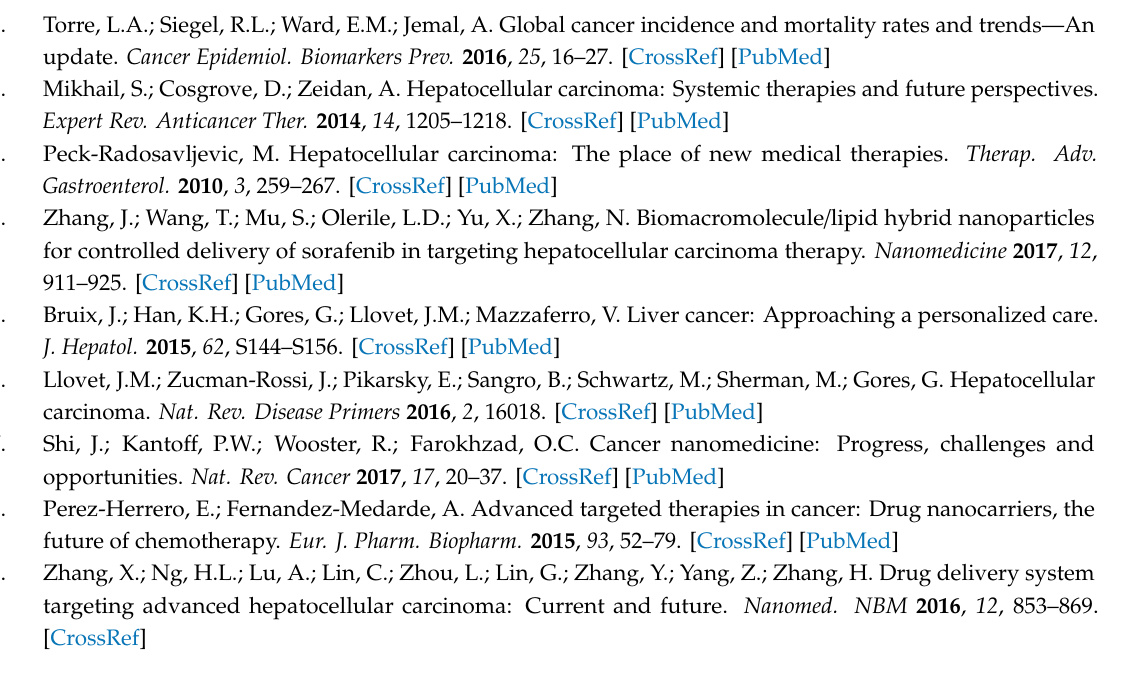
Figure S2: Particle size distribution, physical appearances and drug release profile; Figures S3 and S4: Image J results of cell association, competition assay results; Figure S5: The establishment of HCC orthotopic mice model. Author Contributions: X.Z. and C.L. performed experiments, X.Z. analyzed the data and drafted the manuscript. Z.Y. and H.Z. supervised the whole project and manuscript. W.C. and K.L. provided professional help with the orthotopic mouse model. C.L., A.L., G.L., K.H. and H.S. provided their professional expertise. All